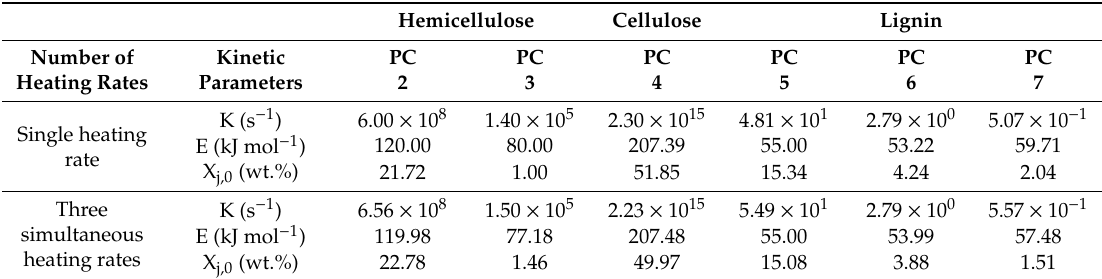
Table 11. Kinetic parameters of each pseudocomponents calculated using a single heating rate and three simultaneous heating rates.